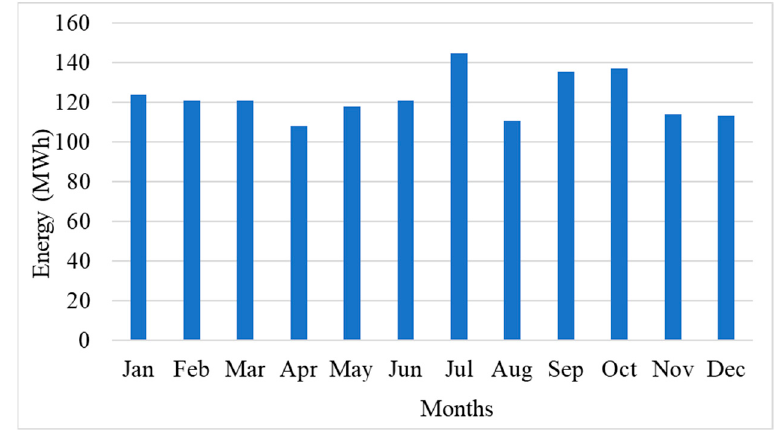
Figure 4. Monthly energy consumption for the HMU campus.